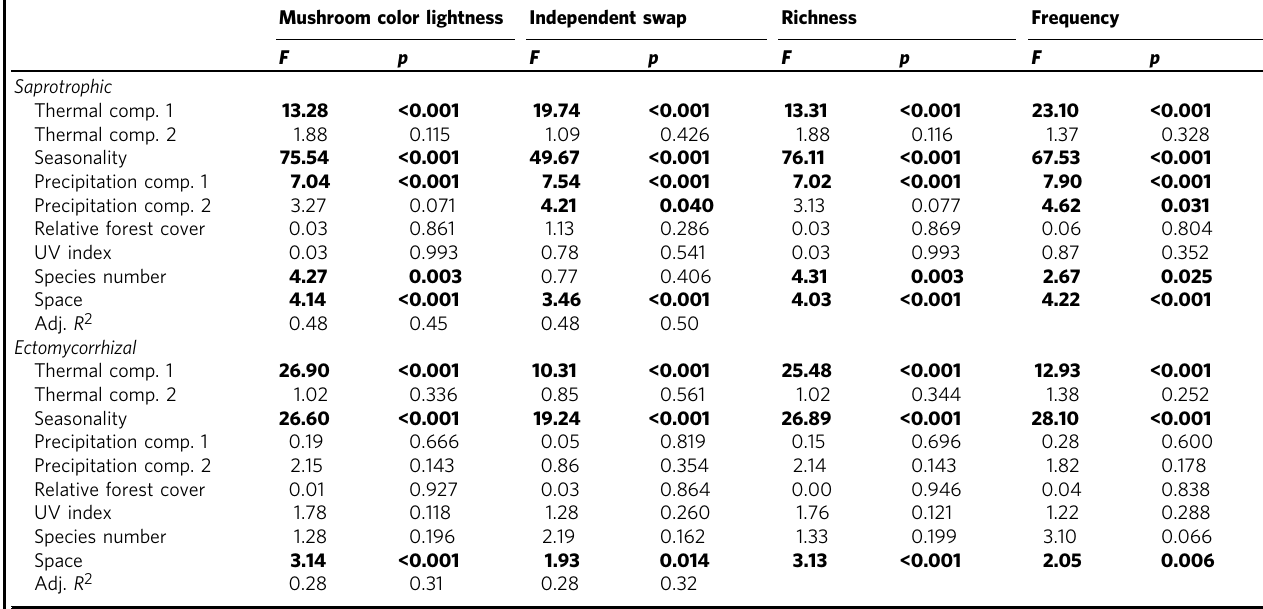
Table 1 Testing the theory of thermal melanism for mushrooms Mushroom color lightness